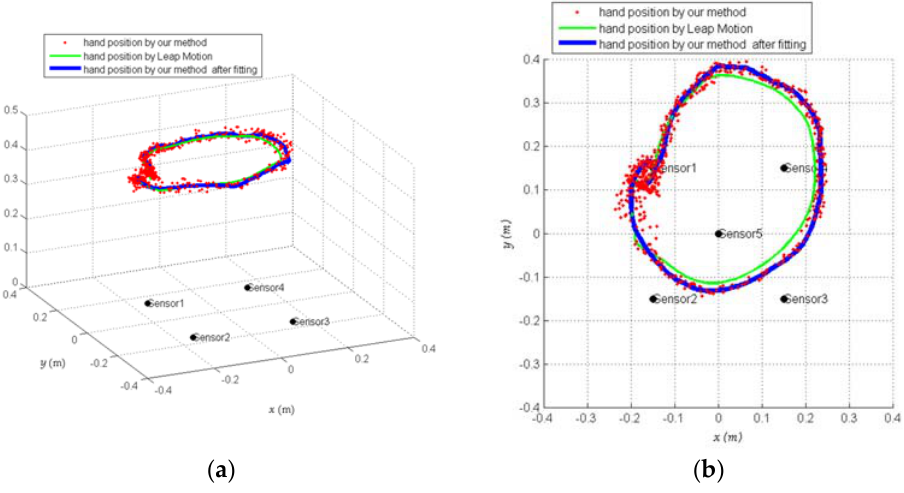
Figure 12. Measured results. ( a ) Side view and ( b ) top view.